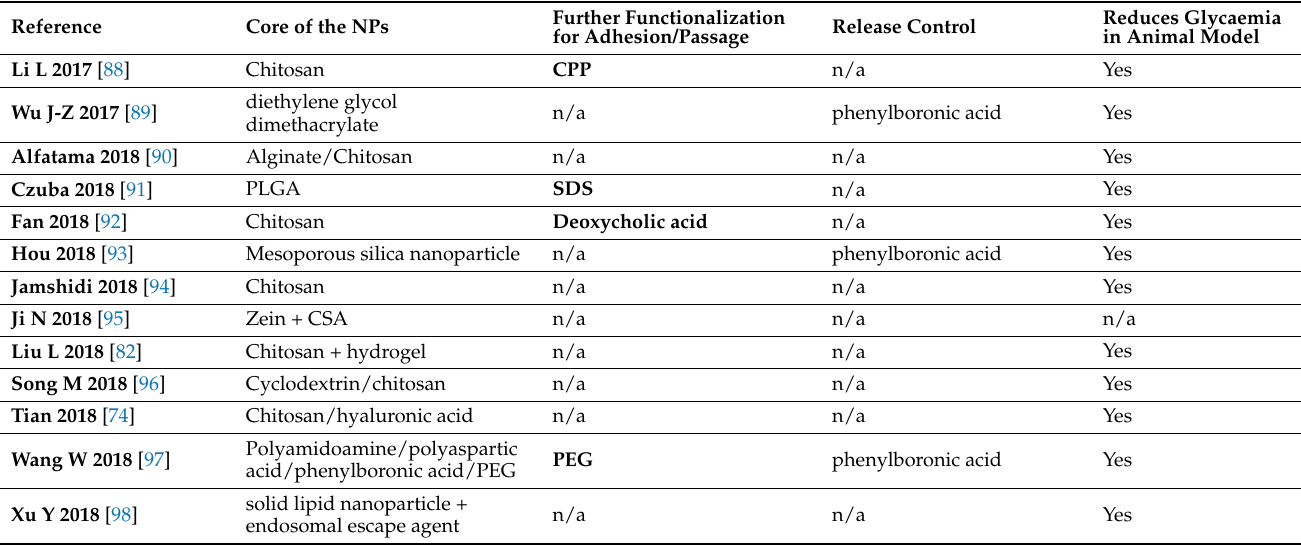
Table 2. Summary of the different NPs and functionalization for the delivery of